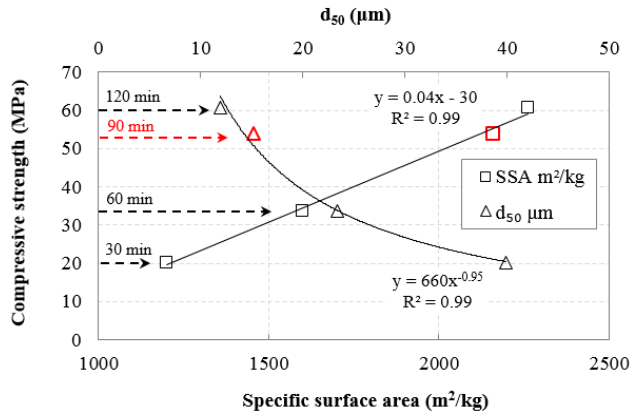
Figure 13. Correlations between compressive strength of AAMs produced and median size (d 50 ), BET specific surface area of slag.